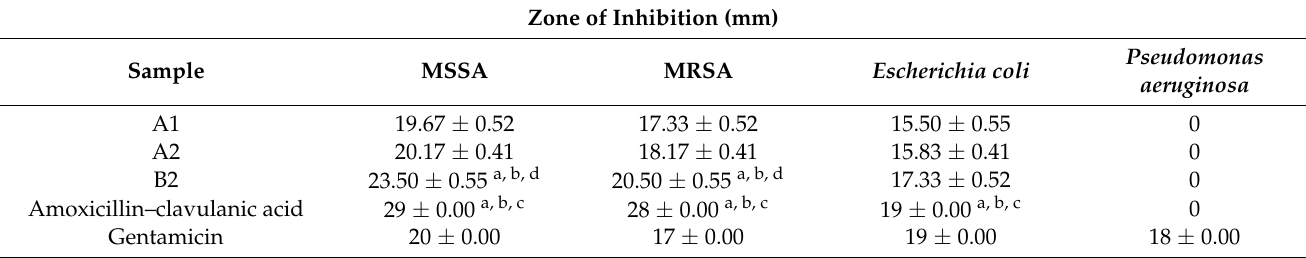
Table 4. In vitroantibacterialactivityofthe D.moldavica samplescollectedusingthewelldiffusion method. Zone of Inhibition (mm)